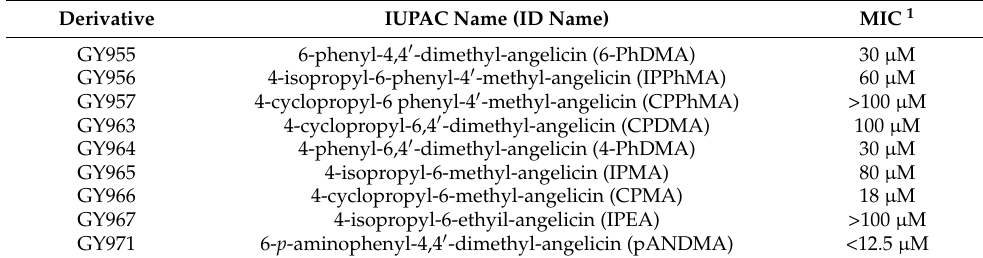
Table 1. MIC values for the TMA analogues in EMSA experiments.